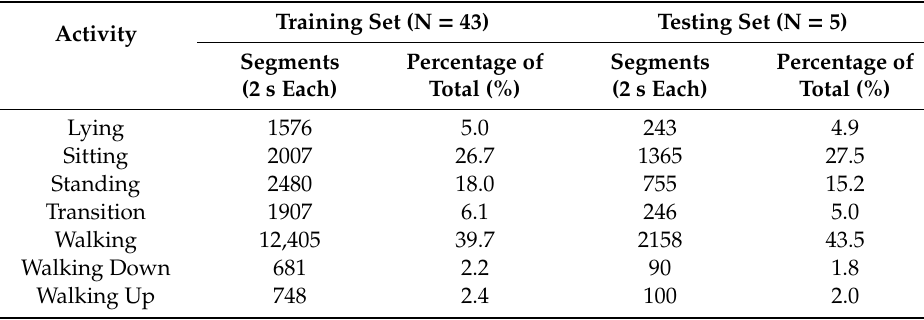
Table 1. Class distributions for the training and testing